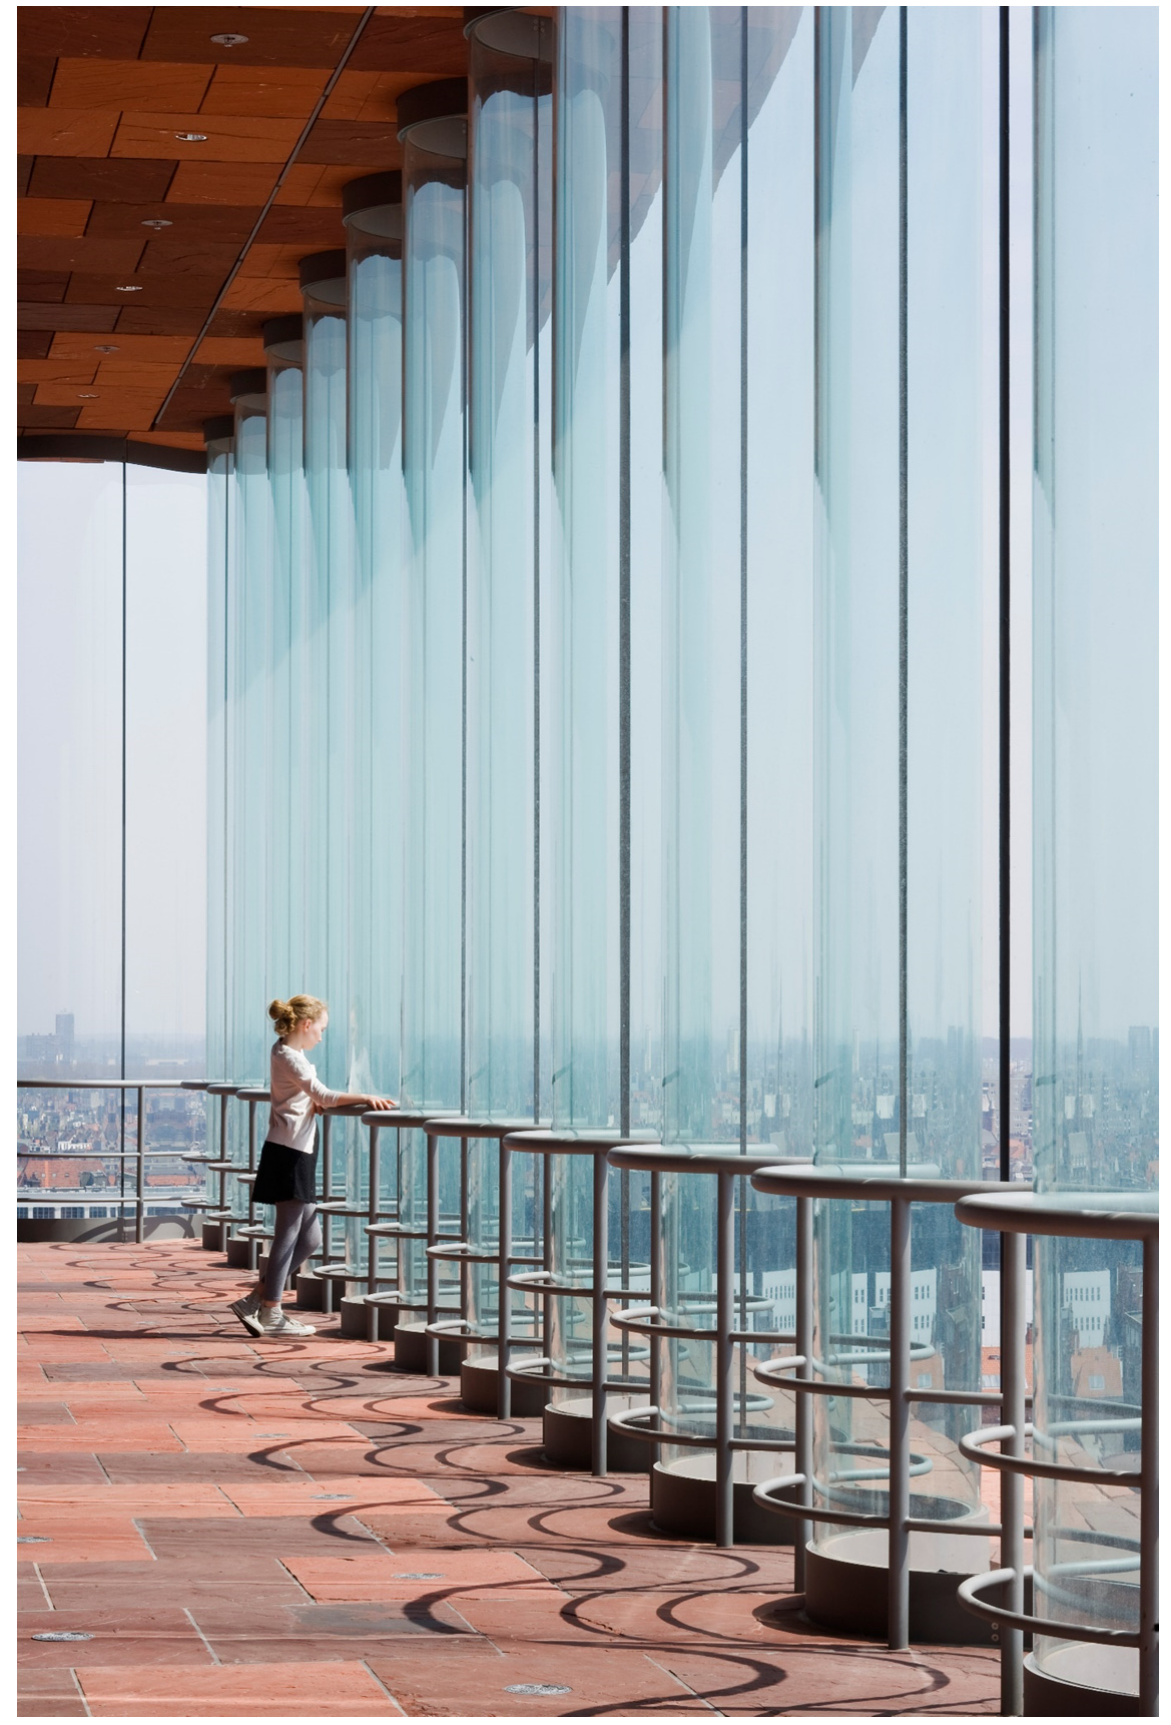
Fig. 5 MAS Museum, inside view of corrugated glass facade. Photography Sarah Blee © Neutelings Riedijk